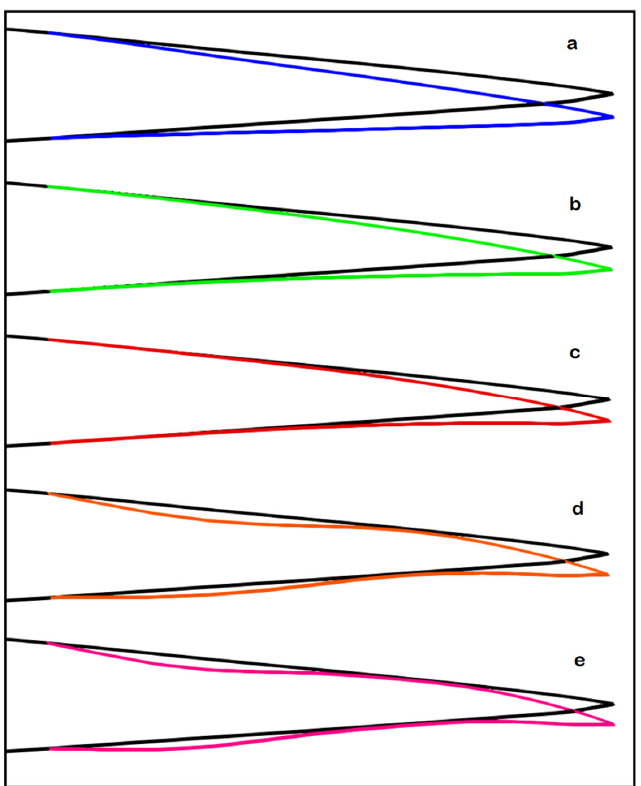
Figure 6. Illustration of the morphing trailing edge for the UAS-S45 airfoil for ( a ) case 1, ( b ) case 2, ( c ) case 3, ( d ) case 4, and ( e ) case 5, after optimization.